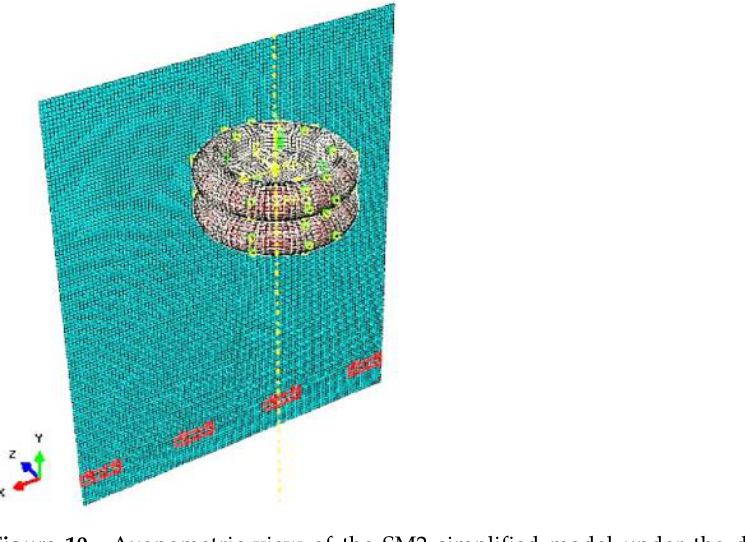
Figure 11. Derivation of equivalent stiffness parameters, as for the SM2 simplified model: ( a ) required translational stiffness, with ( b ) equivalent rotational and ( c ) translational terms.